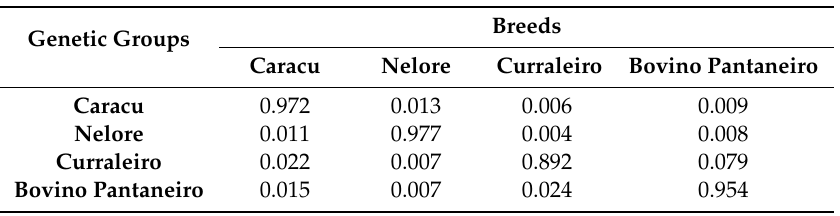
Table 5. Proportion of individuals from each of the four genetic groups of bovines analyzed in relation to the four populations inferred by the STRUCTURE